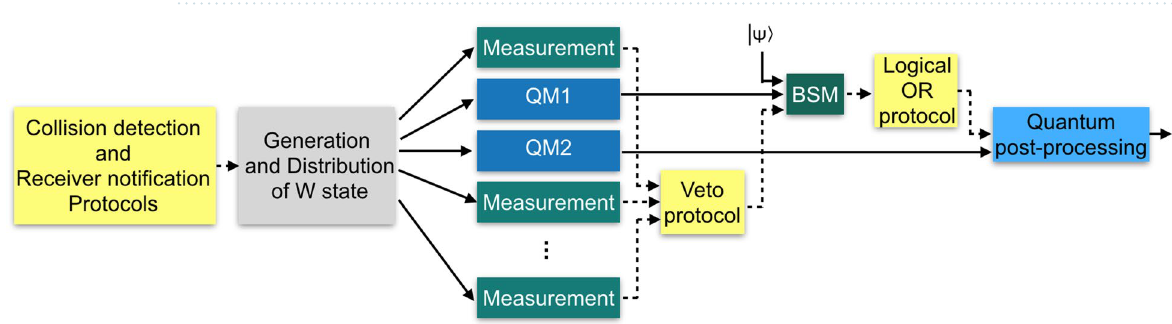
Figure 2. ( a ) P correct versus number of qubit pairs for T = 0.01s and T = 0.1s . ( b ) P forge versus number of qubit pairs for T = 0.01s and T = 0.1s .